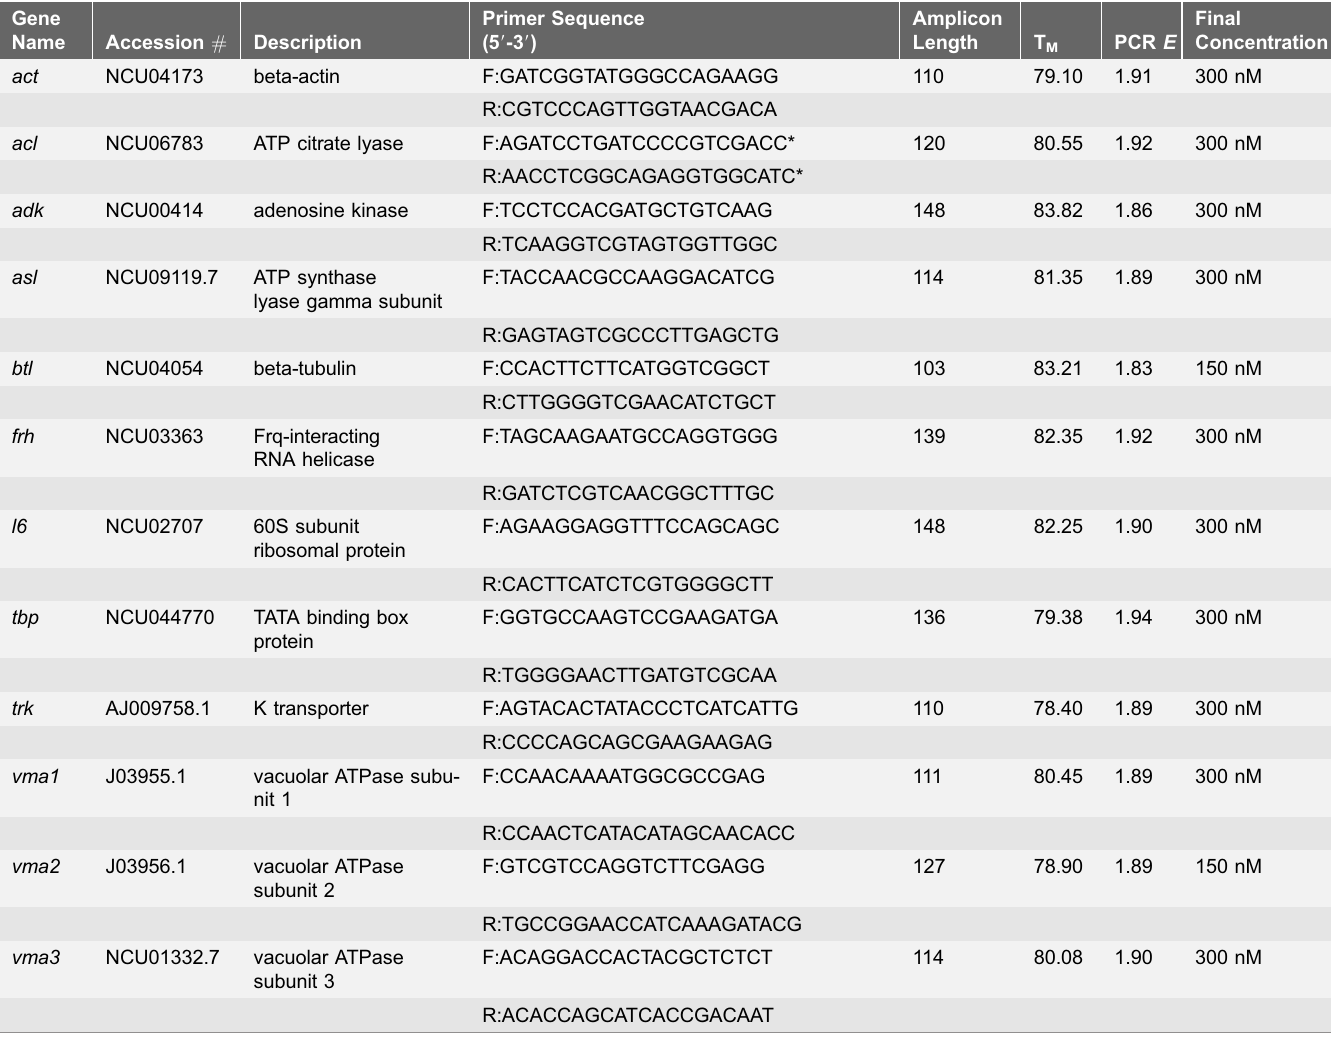
Table 1. List of candidate reference